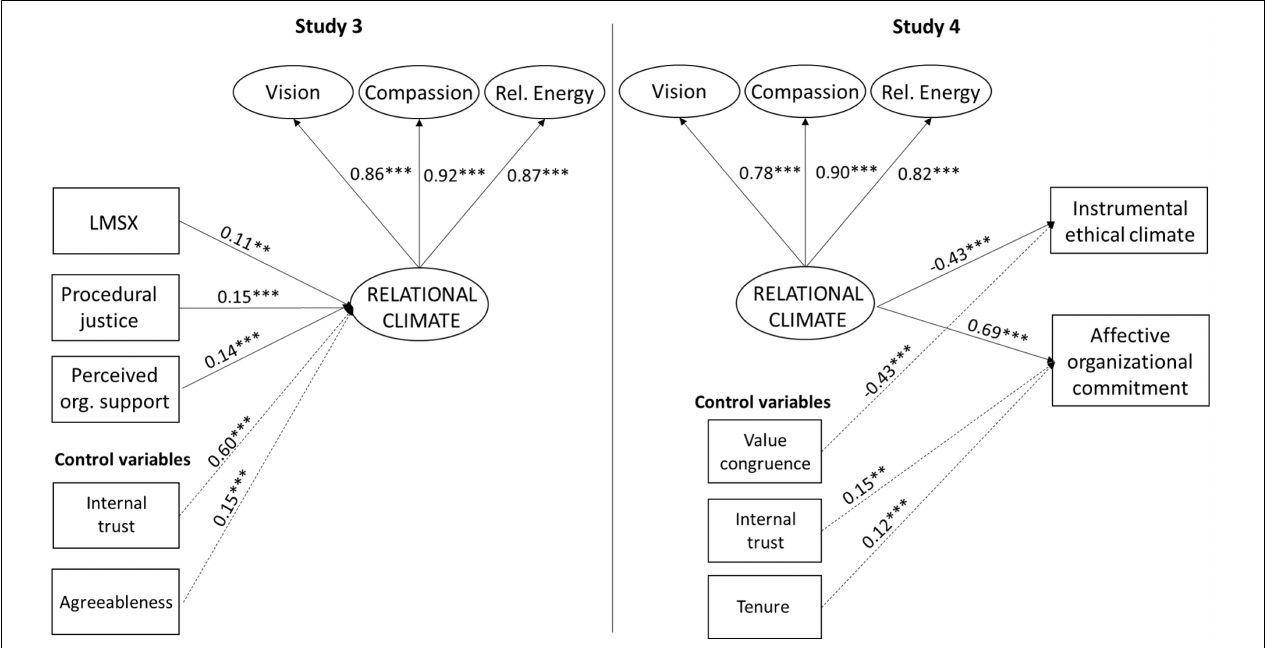
FIGURE 1 | Combination findings from Study 3 and Study 4. Notes: Standardized betas are reported. ∗∗ p < 0.01; ∗∗∗ p < 0.001. Dotted lines represent control variables. Independent variables were allowed to covary. Only significant control variables are reported.